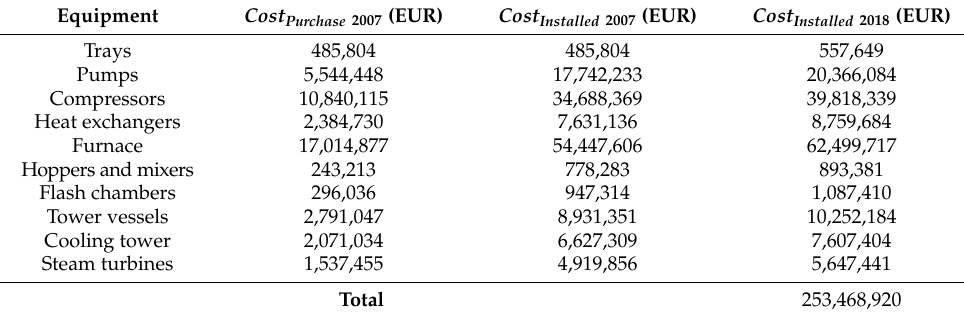
Table 16 lists the cost of all equipment: Table 16. Equipment